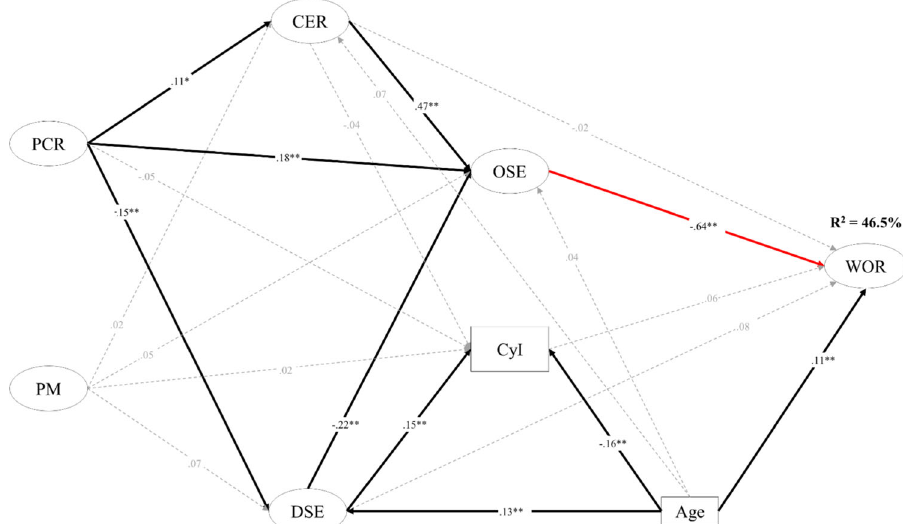
Fig. 2 Results of the multiple-group structural equation modeling (Female group). PCR Parent-child relationship improvement, PM Parental monitoring, CER Cognitive-emotional regulation,; DSE Digital activities for socialization and entertainment, OSE Online learning self-ef fi cacy, CyI Cyberbullying involvement, WOR Perceived worries for future study and life. Black arrows represent statistically signi fi cant direct effect, dotted arrows represent statistically insigni fi cant direct effect, and red arrow represents statistically signi fi cant different direct effect between male group and female group. * p < 0.05. ** p < 0.01.